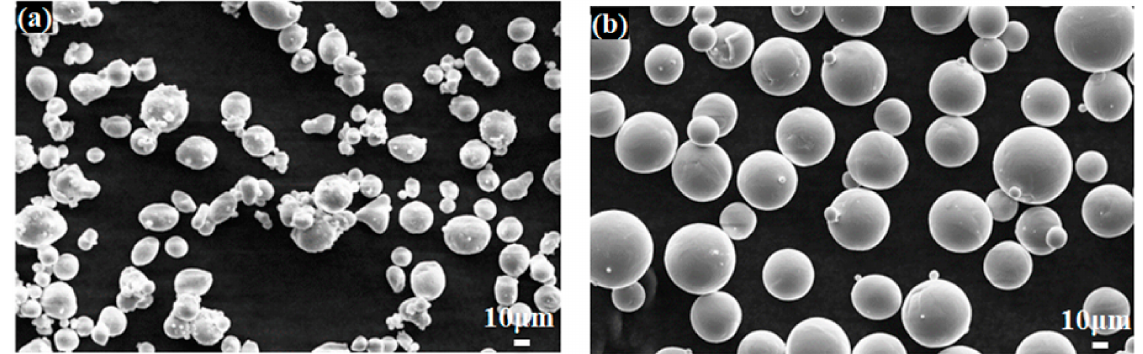
Figure 1. SEM images of feedstock powders ( a ) commercially pure-Al, and ( b ) commercially pure-Ti powders.